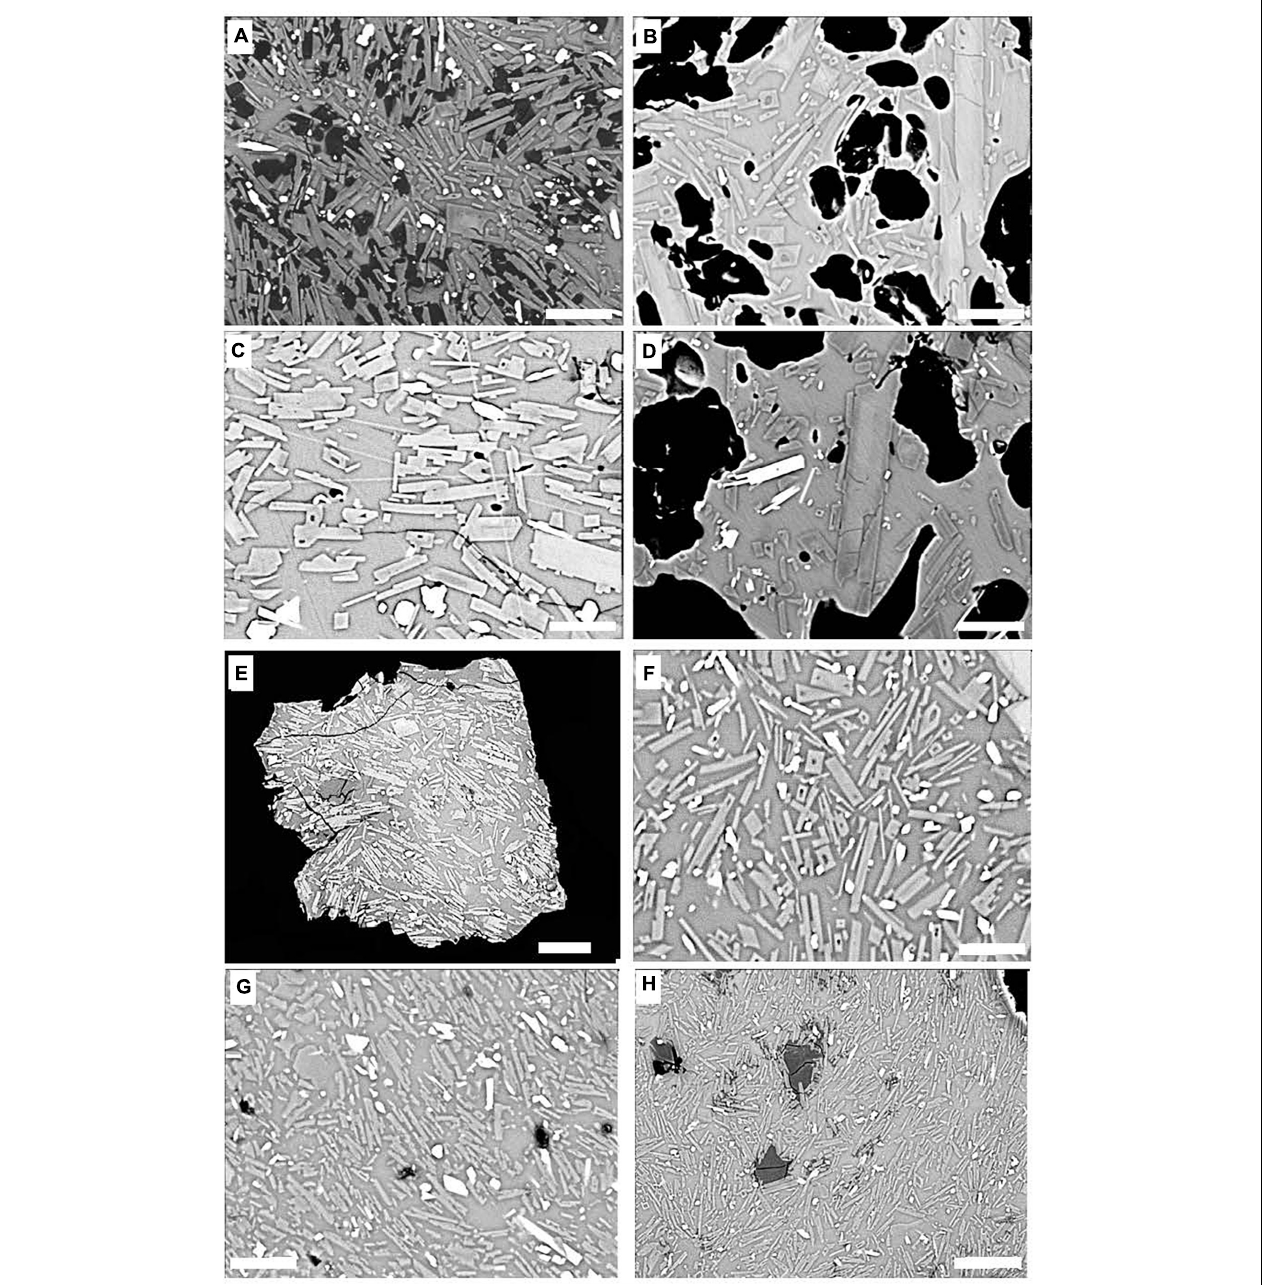
FIGURE 5 | Mount St Helens pyroclasts and precursory ash. The dense black dacite (A,C) has higher crystallinities and crystal number densities than the gray dacite (B,D) . The black dacite has on average a lower vesicularity than the gray dacite. Ash samples from March 28 (E,F) are dense; microlite textures range from complex dendritic clusters (E) to well-aligned individual plagioclase microlites (F) . Samples from an eruption on April 16 (G,H) exhibit a wide range of individual crystal sizes and shapes, from larger, less numerous and more equant plagioclase microlites (G) to fragments with extraordinarily high number densities ( > 3 × 10 5 mm − 2 ) and a Si-phase (H) . Rectangular, gray crystals are plagioclase microlites; dark gray amorphous patches are a Si-phase and black voids are vesicles. Scale bar corresponds to 10 mm in all images except (E) , where the scale bar is 25 mm.